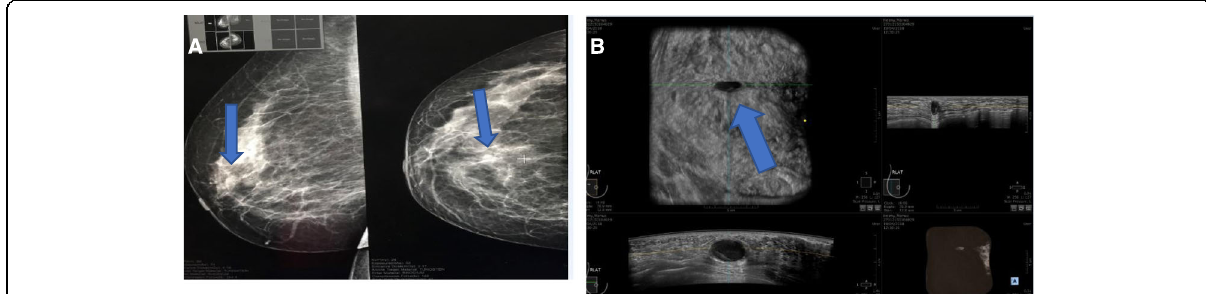
Fig. 4 a Mammogram shows a small dense lesion medio-lateral (left) and craniocaudal (right). b Lesion proved by ABUS with 3D image to be a cyst at 12 o ’ clock in axial and coronal